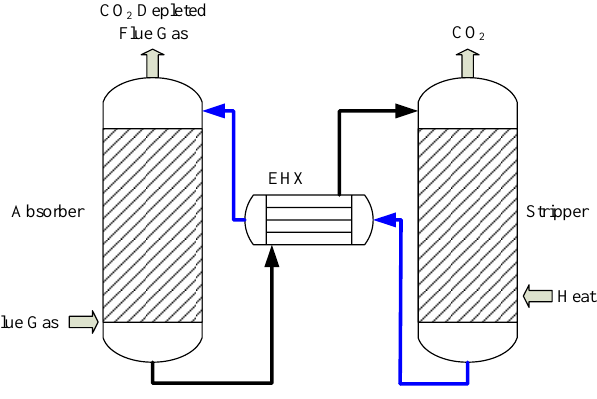
Figure 1. Diagram of a post combustion solvent-based CO 2 capture process.